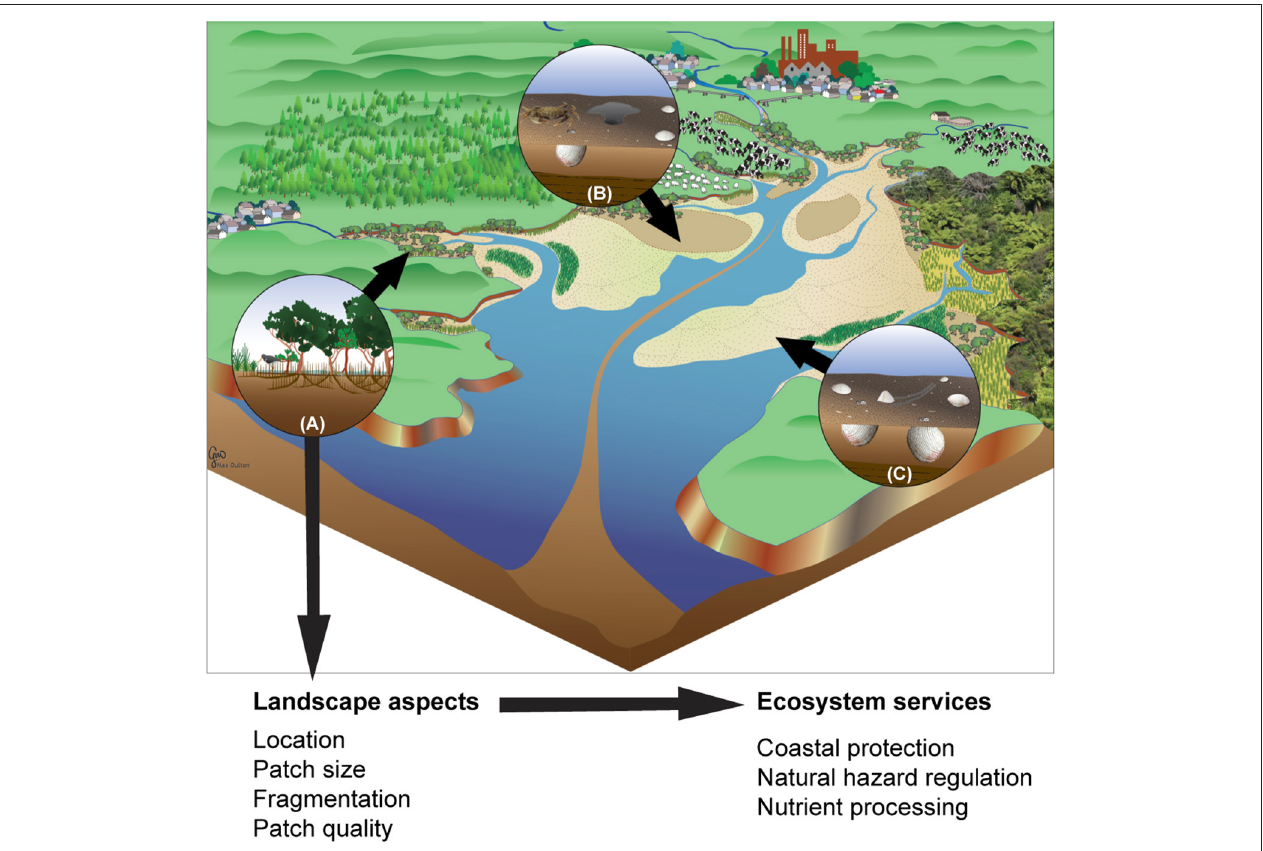
FIGURE 1 | Estuarine habitats that vary in their role in sequestering or exporting materials. Fine sediments are sequestered in mangroves (A) , sediment erosion rates are increased by crab burrows in sandy sediments (B) , and the rate of organic matter transformation and the remineralisation of nutrients are enhanced by the activities of infaunal bivalves (C) . These processes serve to connect habitats by moving material between habitats within the estuary and the surrounding areas. Examples of the connectivity factors and ecosystem services are shown, highlighting not only the performance of specific habitats but also how the arrangement of the habitats within the estuary may influence the effective functioning and service delivery at the scale of the